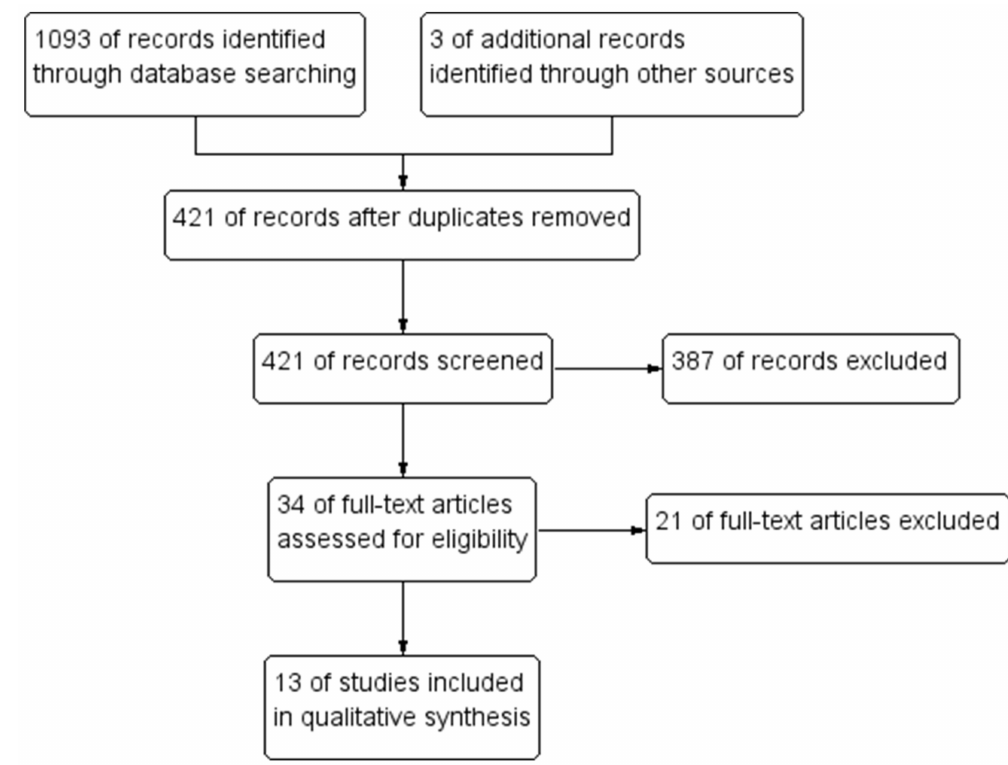
Figure 2. Flowchart of studies selection. Table 1. Characteristics of included